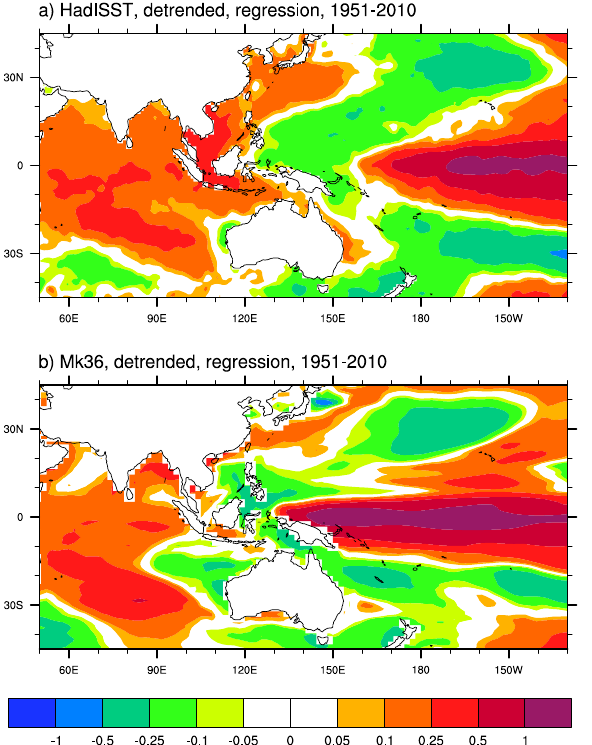
Fig. 8. DJFM gridpoint SST regressed against Ni˜no-3.4 SST (KK − 1 ) for the period 1951–2010, from (a) HadISST observations, and (b) the HIST ensemble. Both data sets were linearly detrended before performing the regression.